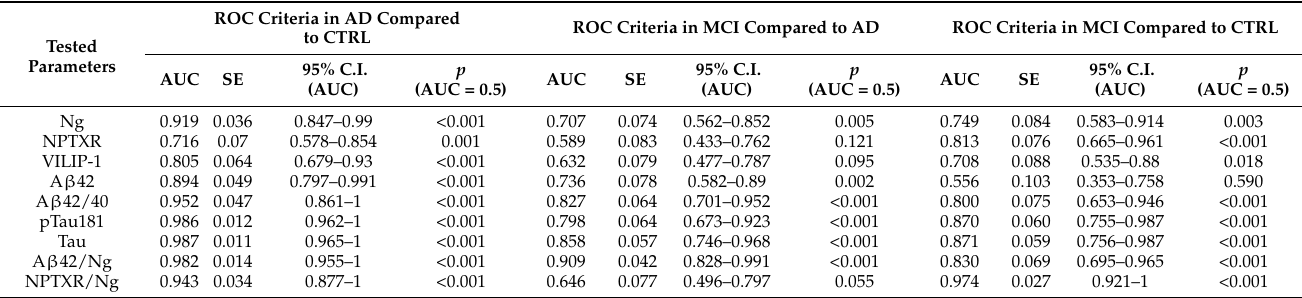
Table 3. AUC of tested parameters in compared